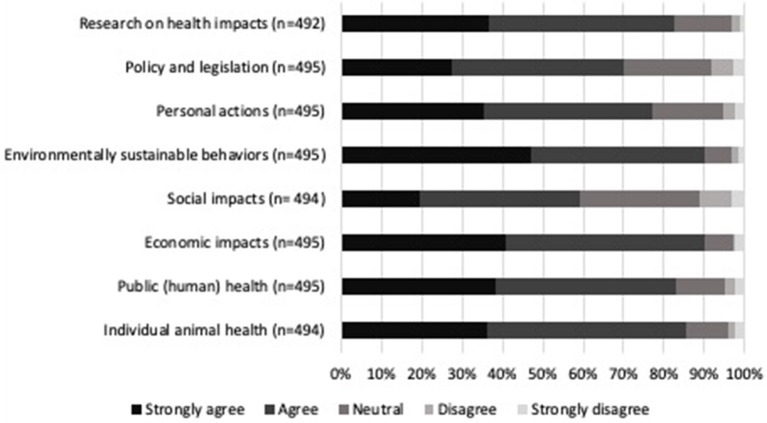
Percentage of level of agreement or disagreement from veterinarians on climate change and health topics that the veterinary community should be knowledgeable about. Complete statements can be found in Appendix 1.